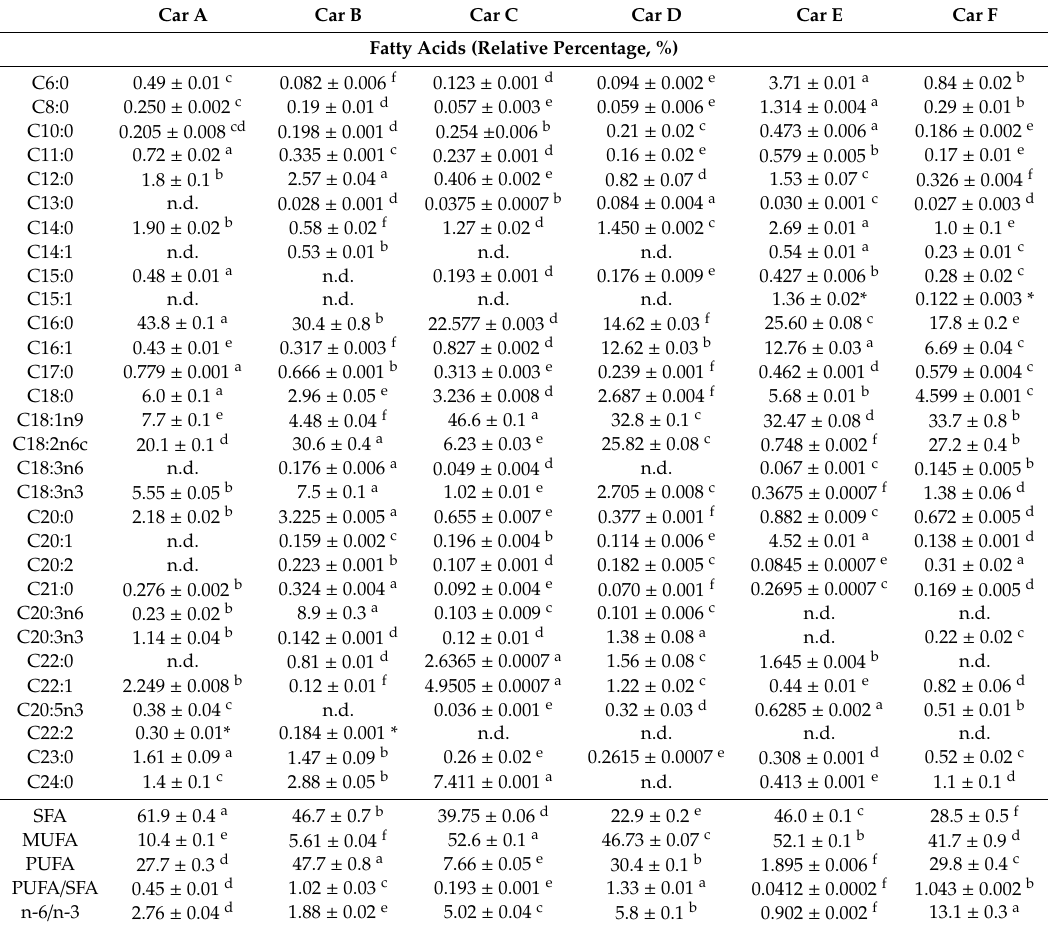
Table 2. Fatty acids composition (relative %) of Cynara cardunculus heads in relation to maturity stage (mean ± SD; n =